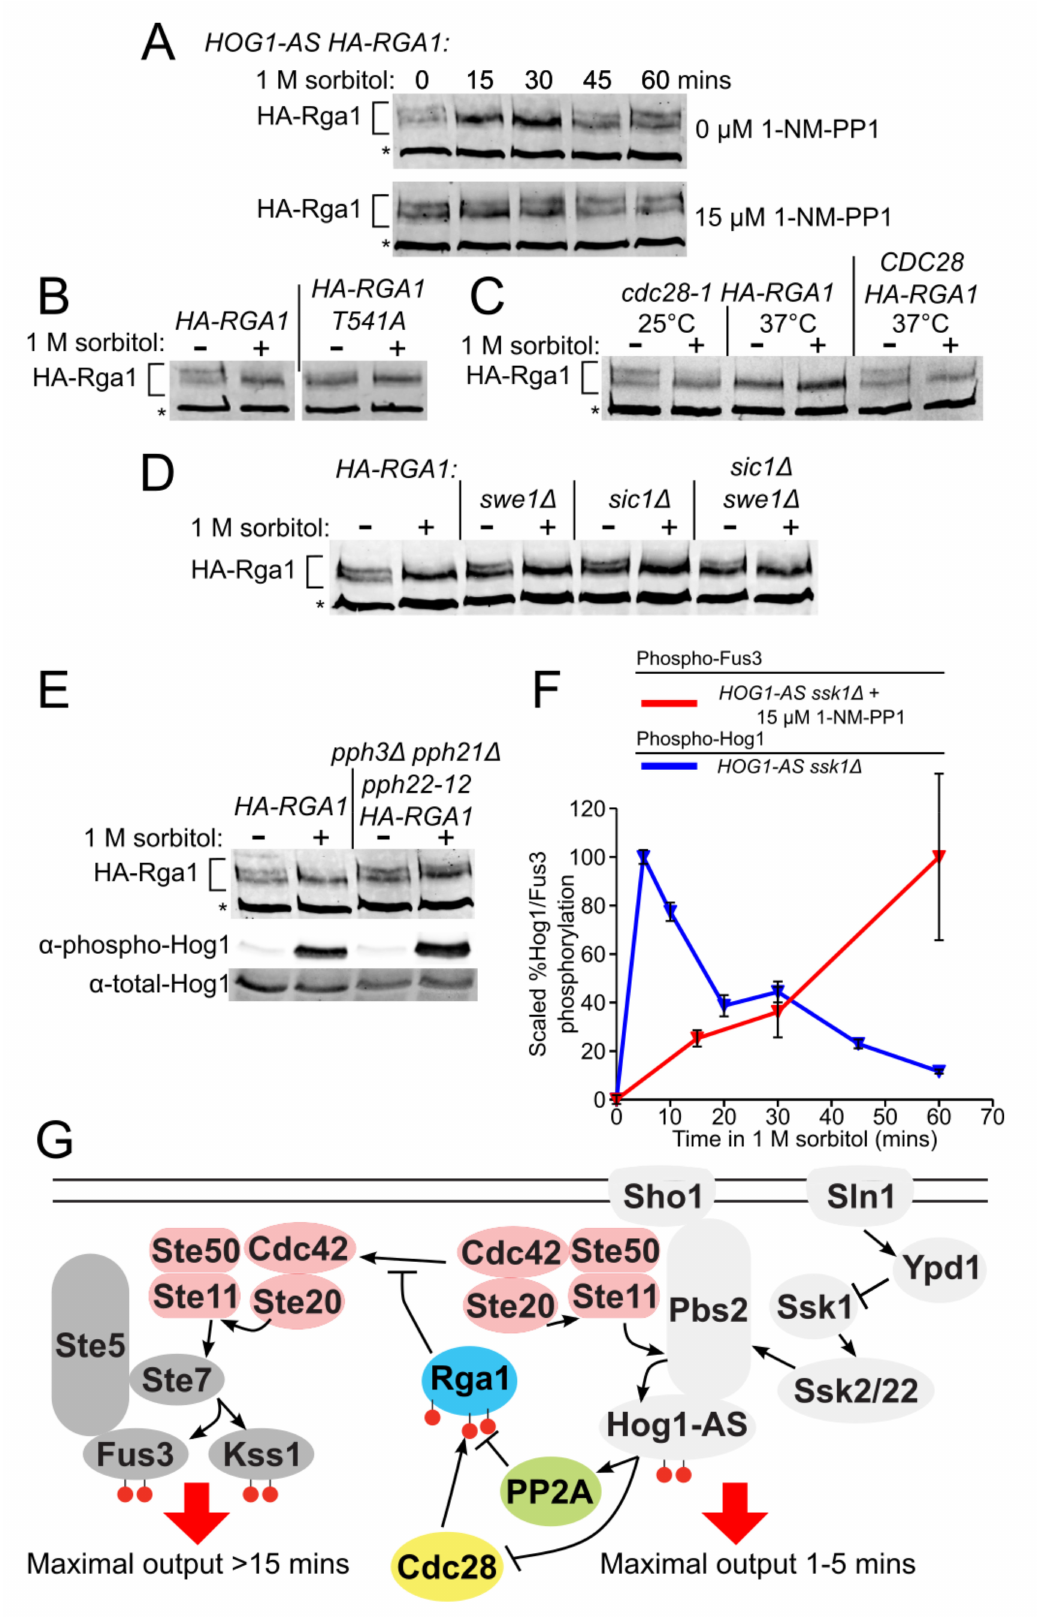
Figure 6. Hog1 action impedes Cdk1-mediated phosphorylation of Rga1 thus promoting its PP2A-dependent dephosphorylation and activation. ( A ) Inhibition of Hog1 maintains Rga1 phosphorylation during hyperosmotic stress. Strain Hog1-as